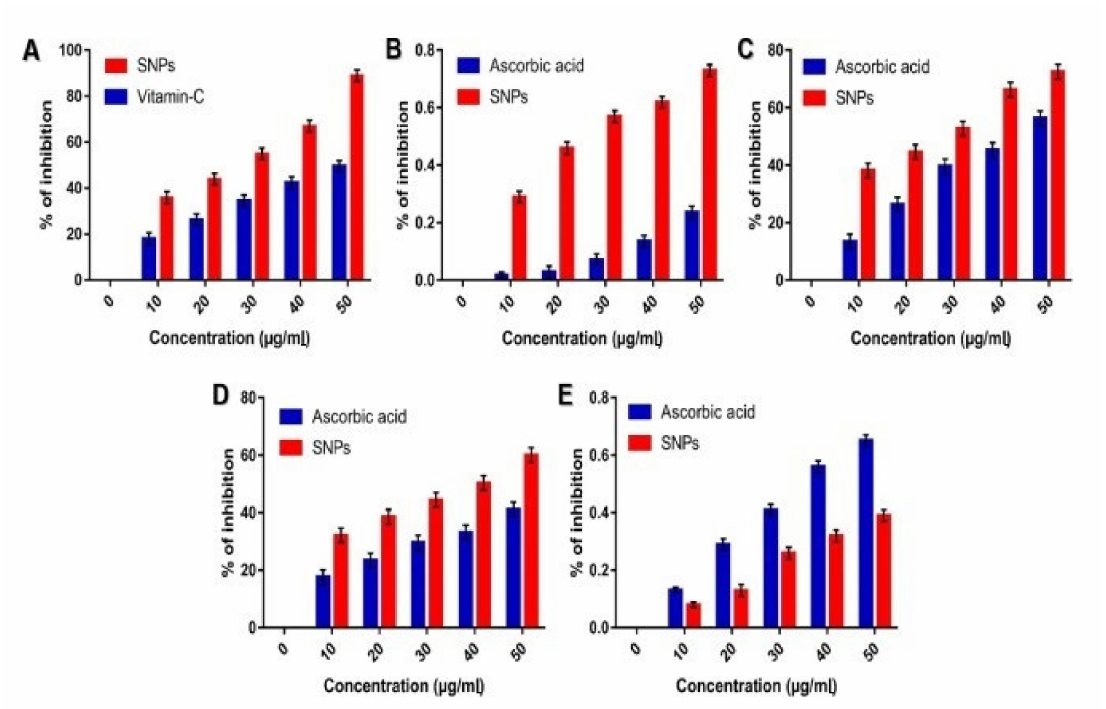
Figure 3. ( A ) DPPH assay, ( B ) total antioxidant activity, ( C ) H 2 O 2 scavenging activity , ( D ) nitric oxide scavenging activity, ( E ) ferric reducing power assay of S. violaceus MM72 exopolysaccharide-mediated AgNPs with their respective standards. The data represent mean ± SD of the three replicates ( n = 3) [155], copyright permission by